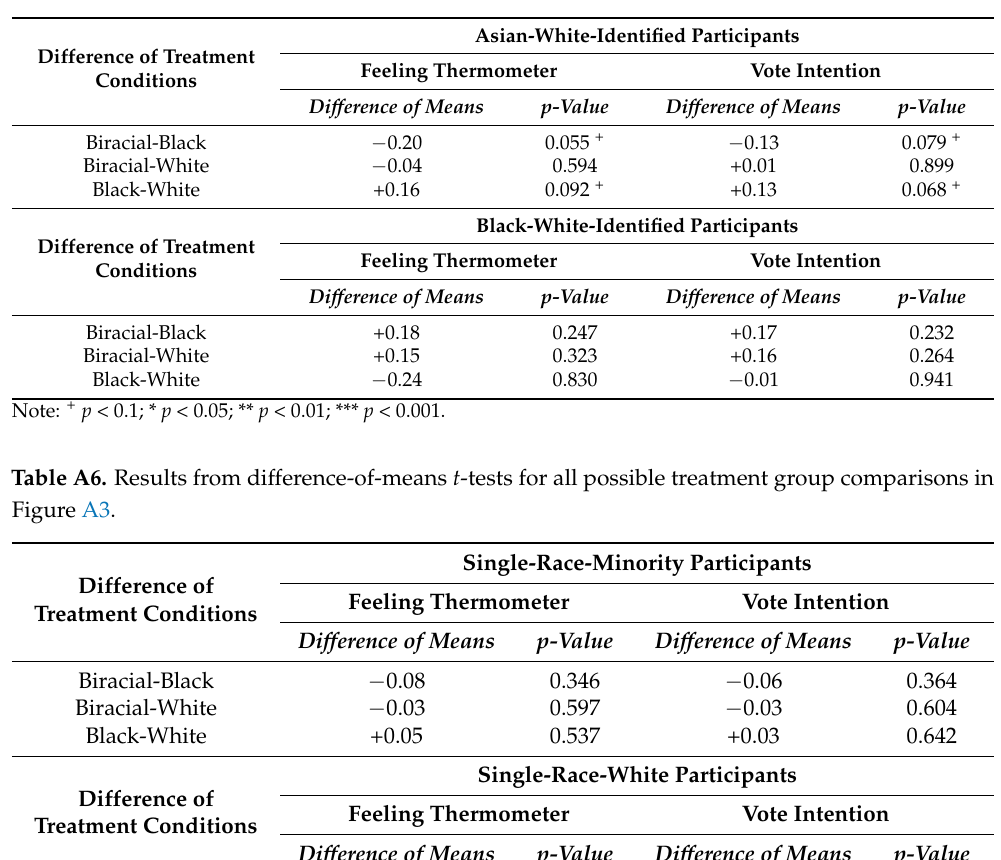
Figure A2. Mean feeling thermometer and vote intention ratings of hypothetical candidates from the Asian and White heritage treatment conditions. Sample includes Asian-White-identified participants (i.e., those who self-identified as Multiracial and used the words “Asian” and “White” to describe their racial identity) and Black-White-identified participants. X -axis denotes different treatment groups based on the identity cued by our hypothetical candidates. Note: error bars denote 95% confidence intervals. Table A5. Results from difference-of-means t -tests for all possible treatment group comparisons in Figure A2.